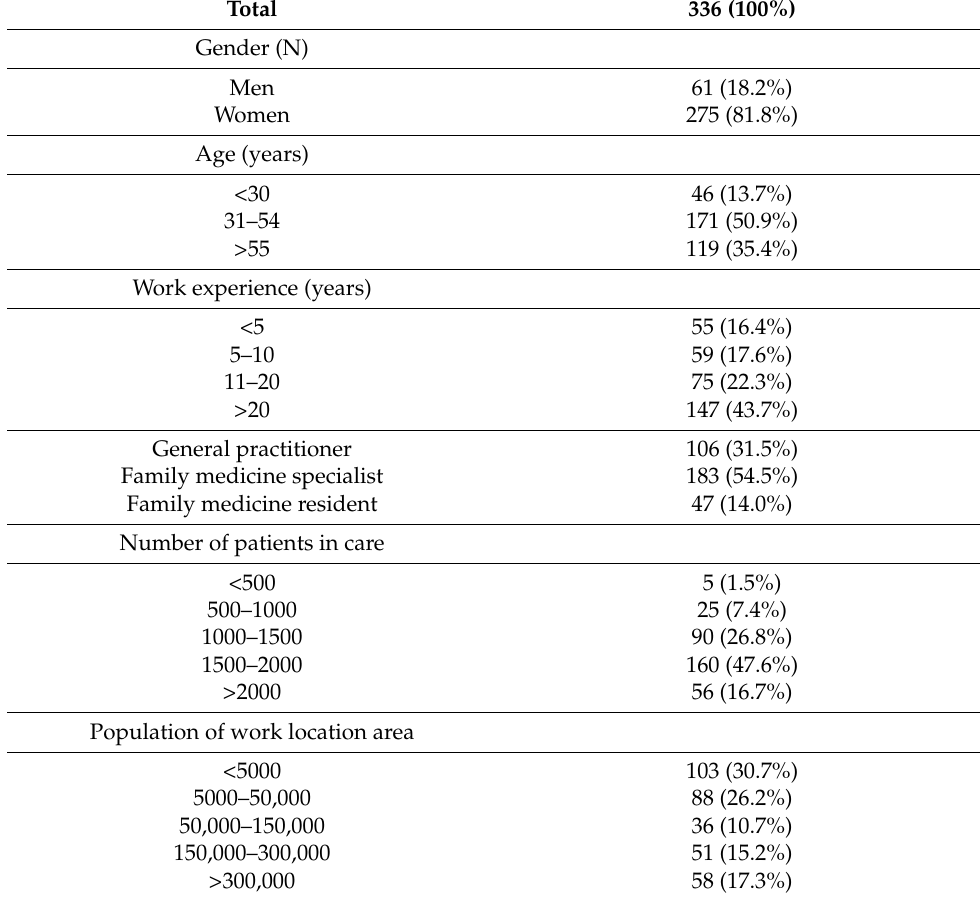
Table 1. Demographic characteristics of study participants.